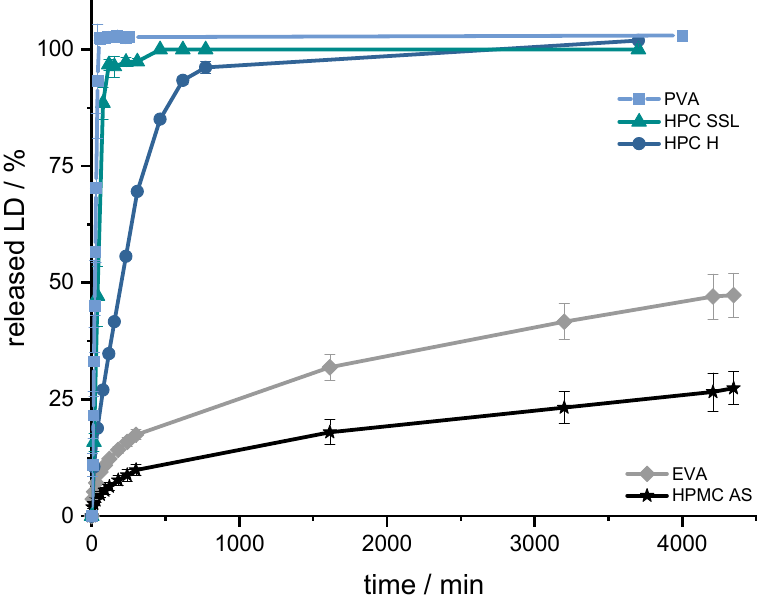
Figure 3. Dissolution profiles of LD from SR-polymer-VCM platelets (33% ( w / w ) LD-loading); modified basket apparatus, 1000 mL 0.1 N HCl, 50 rpm, 37.0 ± 0.5 °C. x ± s; n = 3.